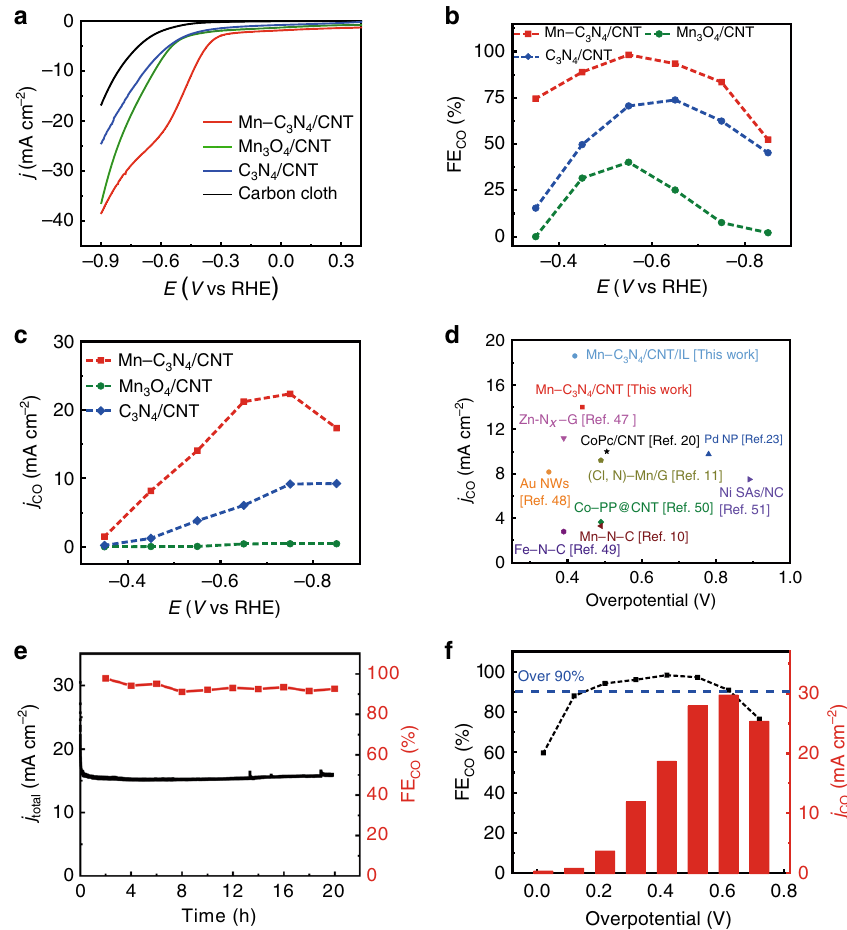
Fig. 3 The CO 2 RR performance over Mn – C 3 N 4 /CNT, C 3 N 4 /CNT, and Mn 3 O 4 /CNT. a LSV curves in the CO 2 -saturated KHCO 3 electrolyte (pH: 7.33, temperature: 25 ± 3 °C, without stirring). b FE CO and c j CO at different applied potentials. d j CO of Mn – C 3 N 4 /CNT at the maximum CO FE compared with those of most state-of-the-art catalysts 10,11,20,23,47 – 51 . e Long-term durability of Mn – C 3 N 4 /CNT operated at − 0.55 V for 20 h. f FE CO and j CO of Mn – C 3 N 4 /CNT at different applied potentials in the CO 2 -saturated [Bmim]BF 4 /CH 3 CN-H 2 O